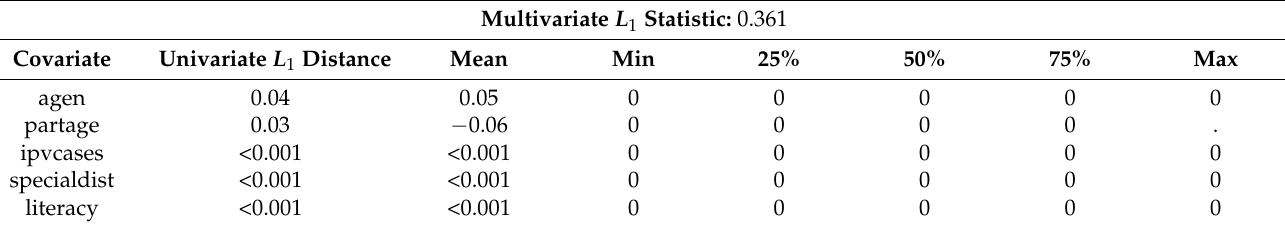
Table 4. Automated CEM summary.